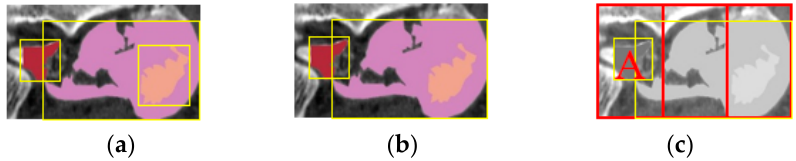
Figure 16. ( a ) Two fragments are in the same region; ( b ) The largest fragment is selected; and ( c ) The